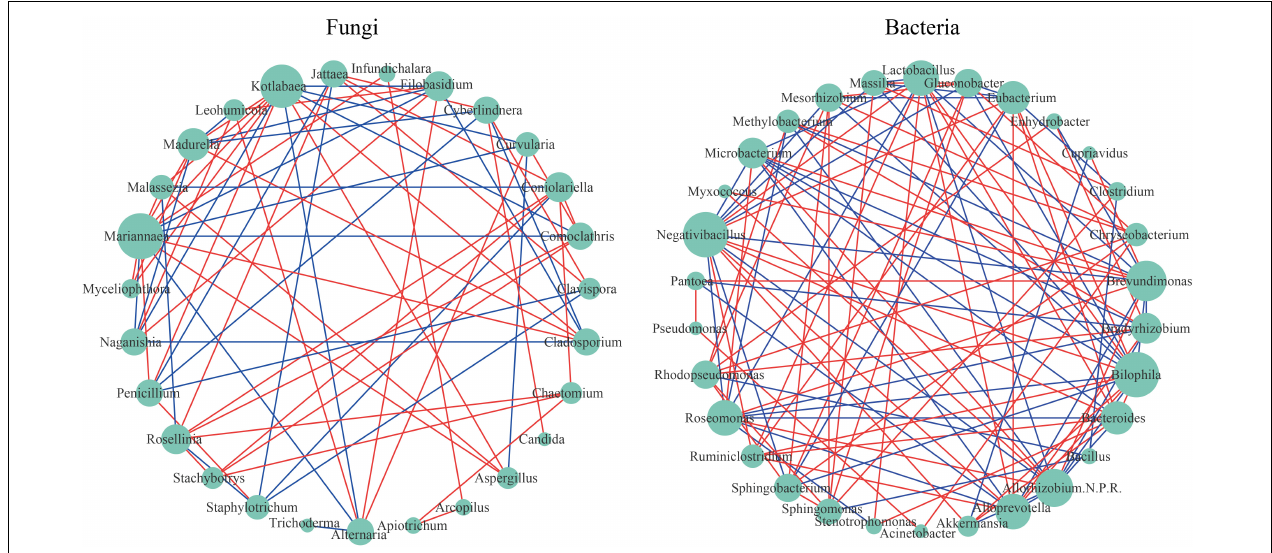
FIGURE 5 | Network visualization shows co-occurrence and exclusion correlations among fungi and among bacteria at the genus level. The green circular nodes represent microbial taxa. Direct connections between nodes indicated strong correlations (Spearman correlation coefficient, r ≥ 0.6; p < 0.05). The color of the edges describes the positive correlation (red) or the negative correlation (blue). The size of the node is directly proportional to the degree of